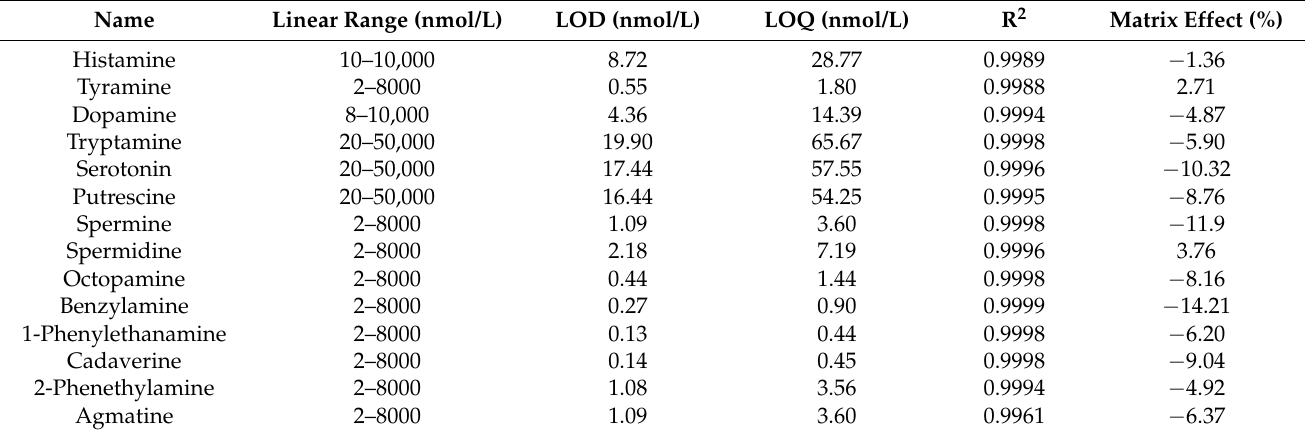
Table 2. Linear range, R 2 , LOD, LOQ, and matrix effect of 14 BA